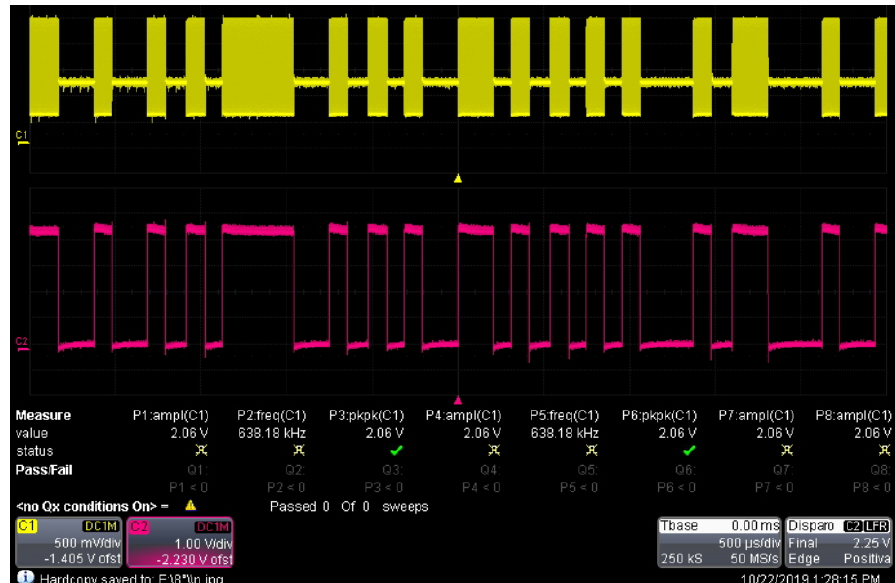
Figure 7. ASK modulation tests.